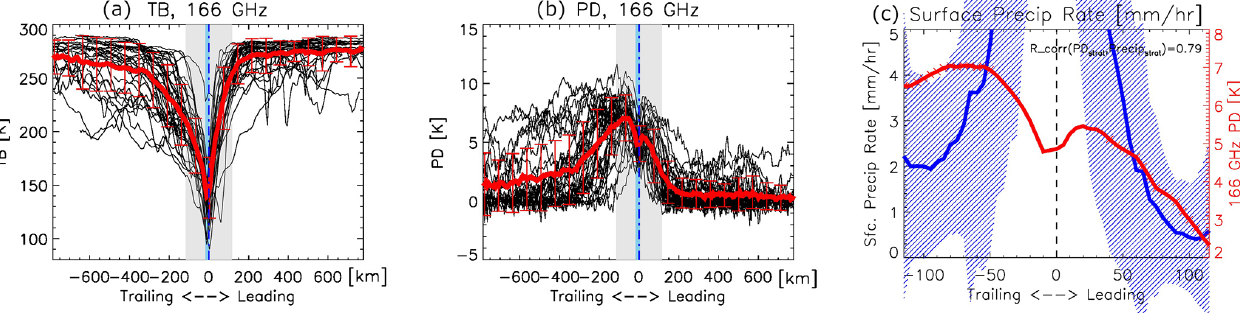
Figure 9. The 166GHz TB (a) and PD (b) distribution across the squall line center (0 at horizontal axis) for all 47 squall line cases (black) and their mean (thick red) and standard deviation (thin red error bars). The trailing edge is to the left and the leading edge is to the right. The squall line case details can be found in Table A1 in the Appendix. Light grey rectangles in (a) and (b) correspond to KuPR coverage. In (c) , mean surface precipitation rate (PR sfc ) retrieved from KuPR is displayed as the thick blue line across the squall line center with standard deviation shown in blue hatched areas. The 166GHz PD in the grey area in (b) is overlaid as the thick red line in (c) . Deep convective rainy footprints (PR sfc > 5mm/h) are excluded for plotting because our PD hypothesis only works at the stratiform region. The Pearson rank correlation between PR sfc and PD is 0.79 (significance at 99.9% confidence level) after excluding the deep convective